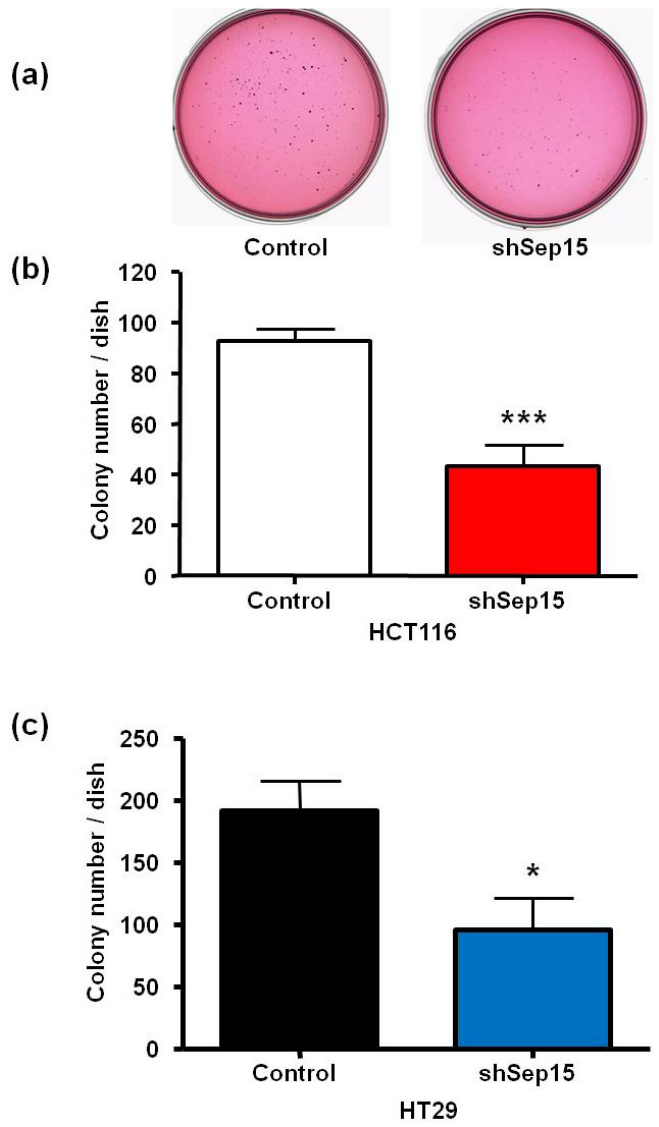
Figure 4. Effects of Sep15 deficiency on anchorage-independent colony formation in soft agar as quantitated by staining cell colonies with p -iodonitrotetrazolium overnight. ( a ) Representative soft agar dishes with stained colonies of HT29 cells after 20 days; numbers of colonies of ( b ) HCT116 cells and ( c ) HT29 cells. Values are mean ± SE ( t -test, n =